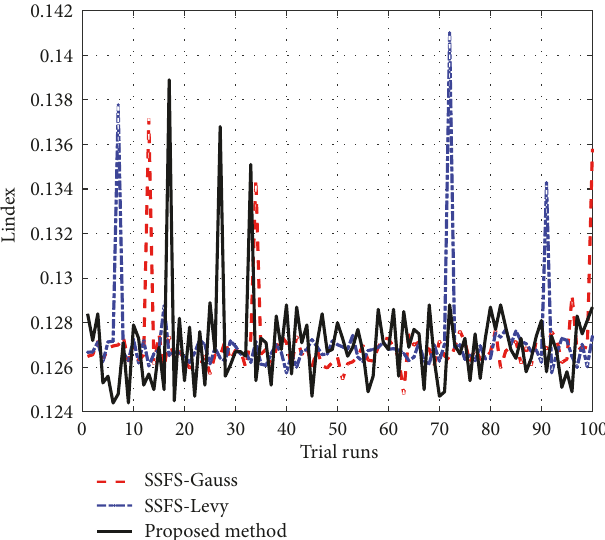
Figure 6: Comparisons of 100 runs for L-index objective of IEEE 30-bus system obtained by three methods.